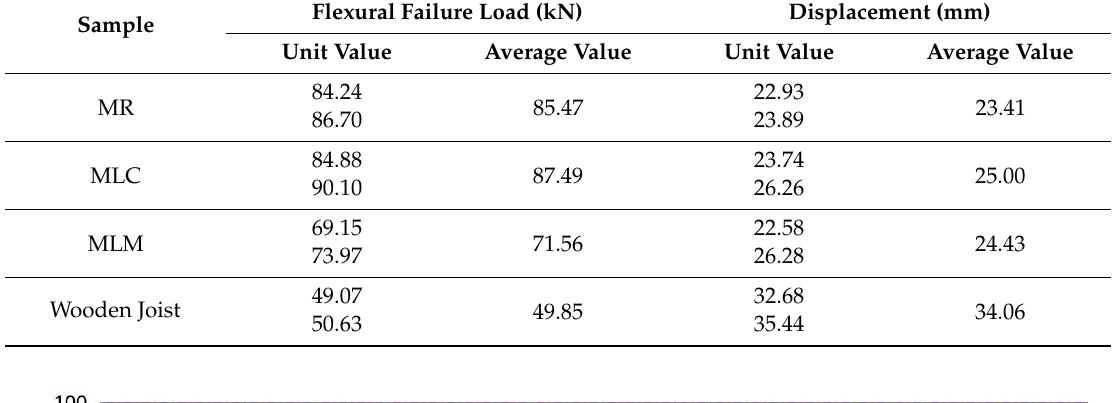
Table 6. Results of the full-scale flexural test.